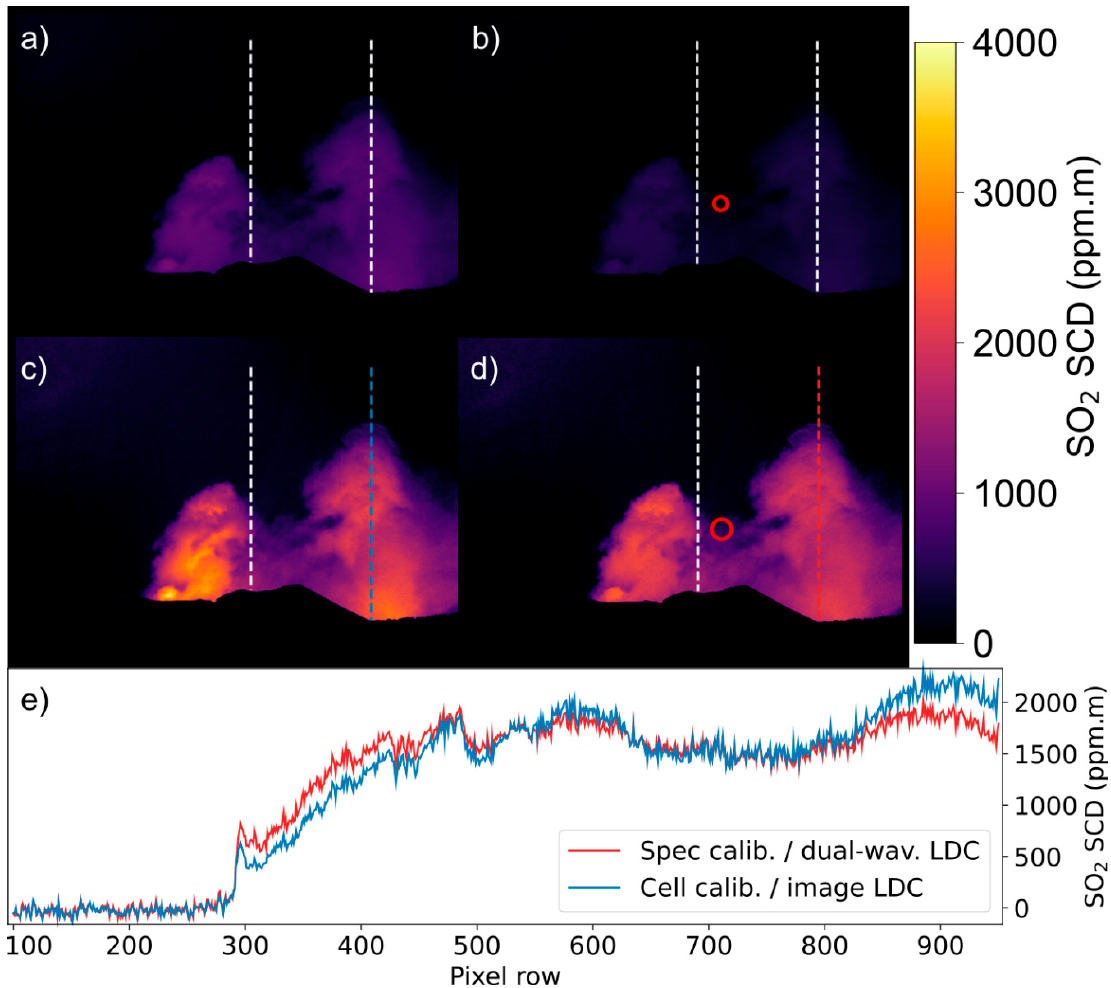
Figure 4. A single SO 2 camera image captured on 15 January 2018 at 11:35 local time, as calibrated and corrected using the different methods. White, blue and red dashed lines show the plume speed correlation lines; ( a ) shows the results from using cell calibration without dilution correction; ( b ) is from calibrating the SO 2 camera using an uncorrected spectrometer, with the correlated field of view of the spectrometer plotted as a red circle; ( c ) shows the SO 2 image produced by correcting the optical depth images for light dilution then using the cell calibration; ( d ) is the image calibrated using a light dilution- corrected spectrometer, again with the correlated field of view shown. The correlation for this circle is separate to that of ( b ), producing the different sized circle. Note the change in SO 2 distribution between the two corrected SO 2 images; ( e ) the SO 2 SCD found along the blue and red plume speed correlation lines in ( c ) and ( d ) are plotted for easy comparison of the plume distribution. These SCDs have been corrected for residual in the image optical depth.